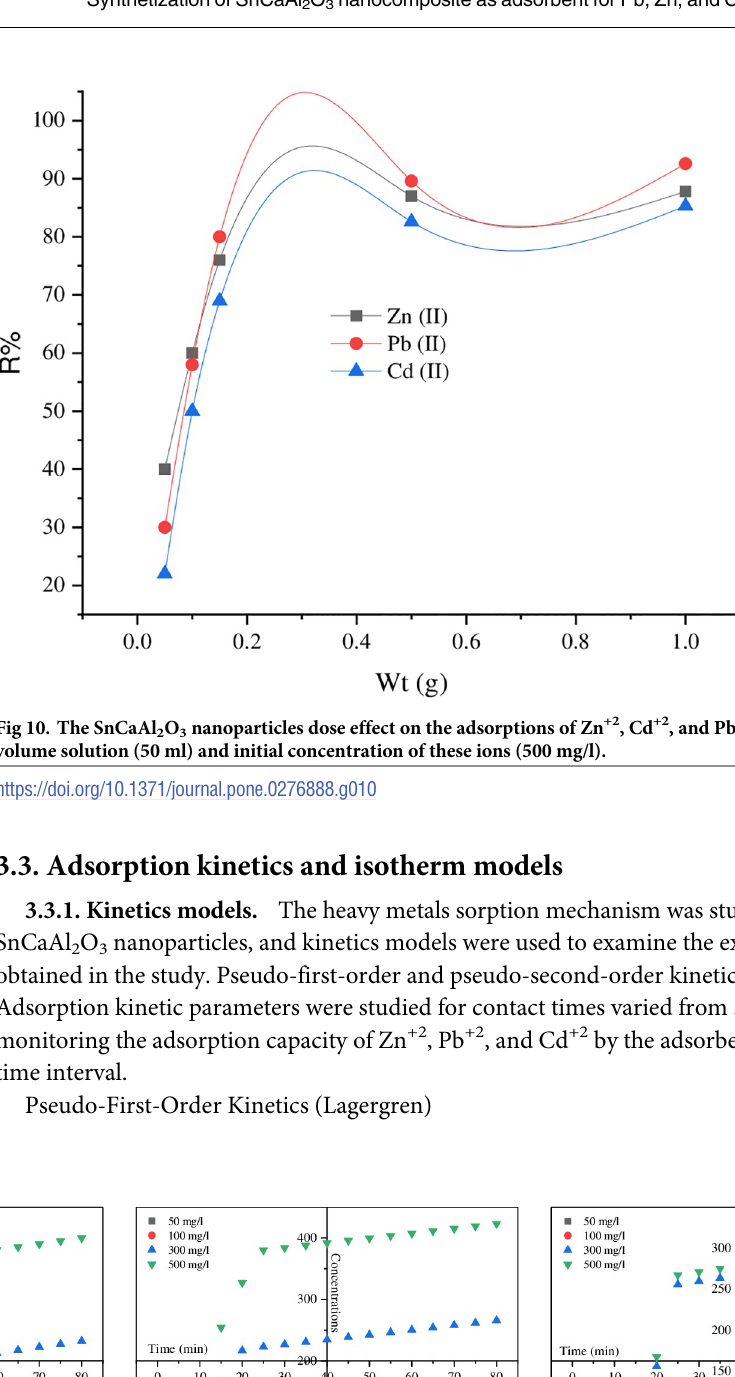
PLOS ONE | https://doi.org/10.1371/journal.pone.0276888 November3,